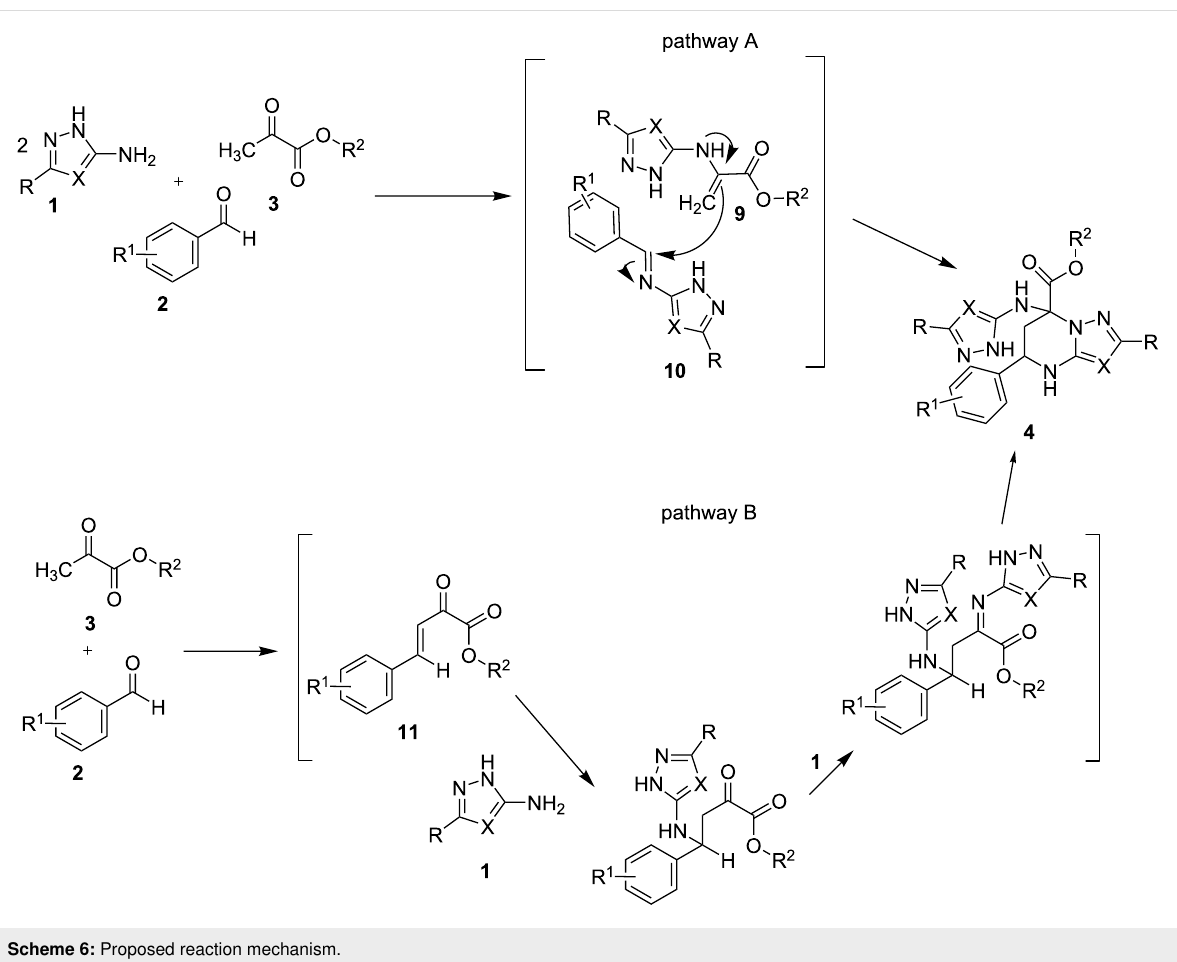
Scheme 6: Proposed reaction mechanism.